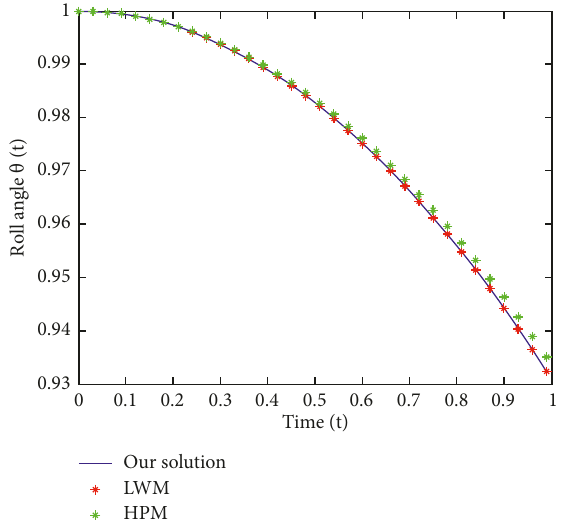
Figure 4: Comparative study of Genocchi polynomial, LWM, and HPM for roll angle with respect to the time t values (in sec) for